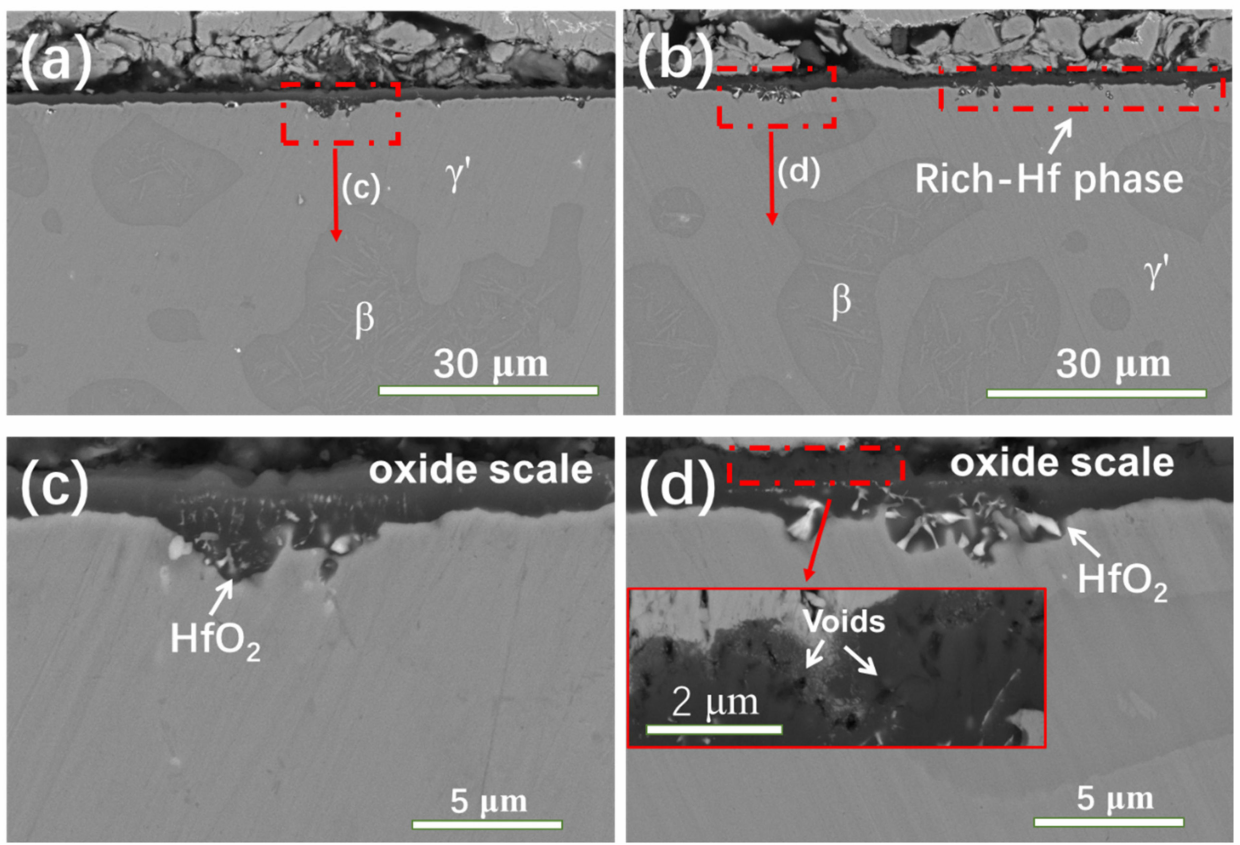
Figure 6. The cross-sectional morphologies of the oxide scale formed on the NiCrAlHf bond coat alloy after 24 h of oxidation at 1100 ◦ C in a water vapor atmosphere during ( a ) stepped heating; ( b ) constant heating; ( c ) the high magnification area of ( a ); ( d ) the high magnification area of ( b